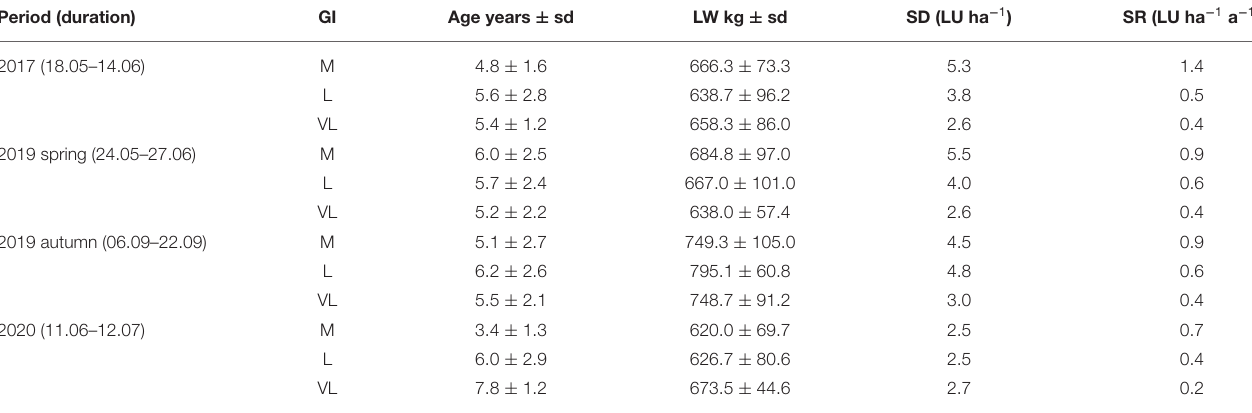
TABLE 2 | Overview of the grazing management and treatments during the investigated periods and annual stocking rates. Period (duration)